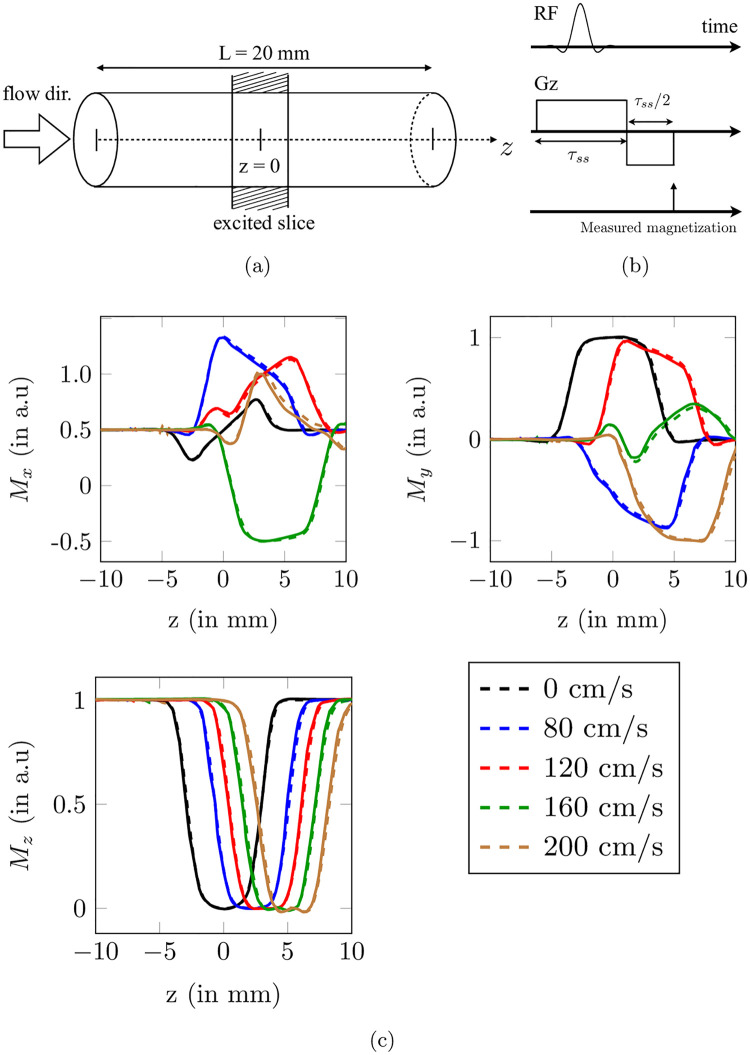
(a) Schematic illustration of the flow configuration used in Yuan et al. [31]. (b) 90° slice selective excitation sequence simulated. (c) Evolution along the centerline of the magnetization (Mx, My, Mz) for several velocities imposed to the particles. The dashed lines correspond to the YALES2BIO simulation results, while solid lines correspond to Yuan et al. data [31].